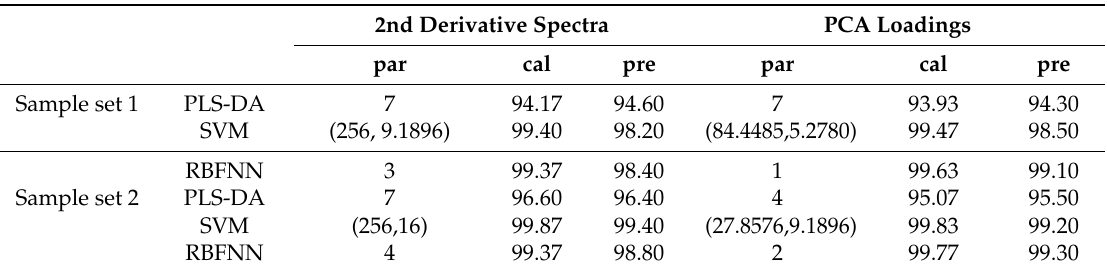
Table 5. Results of discriminant models using optimal wavelengths of pixel-wise spectra of sample set 1 and